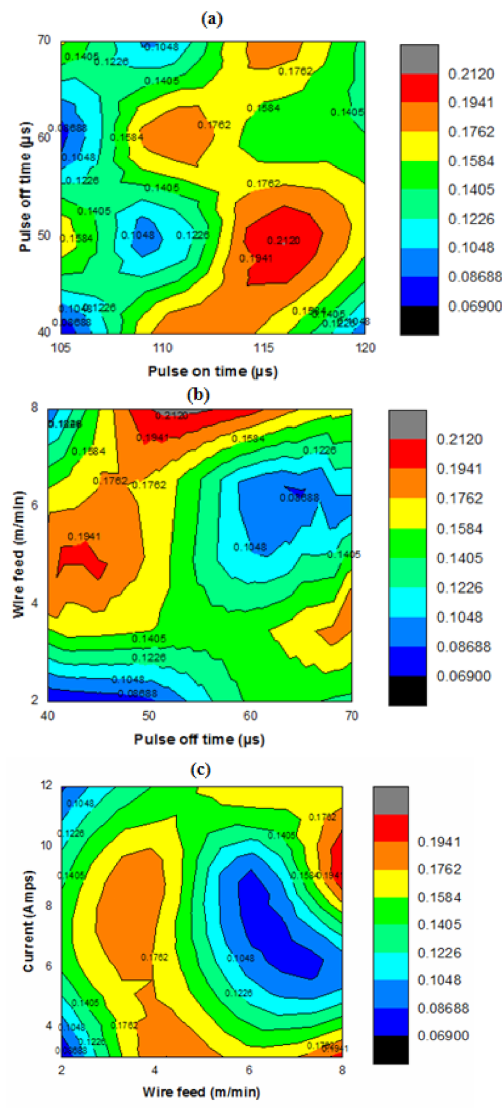
Figure 8. Contour plot of ( a ) pulse on time ( µ s) vs. pulse off time, ( b ) pulse off time ( µ s) vs. wire